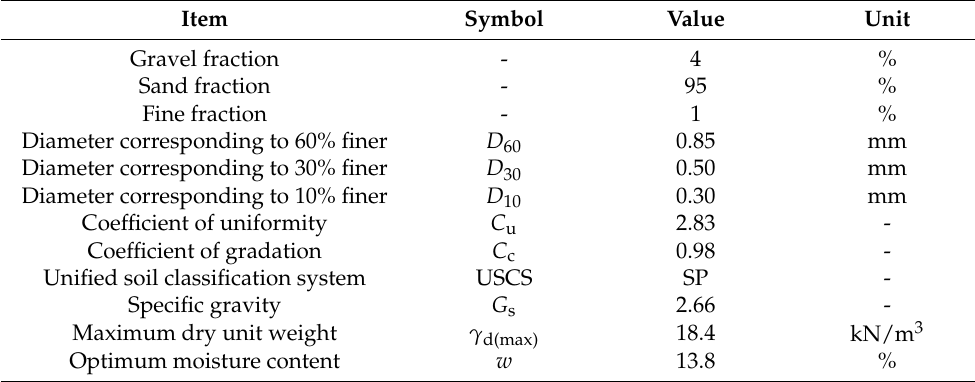
Figure 1. ( a ) cement, ( b ) sand, ( c ) SEM photo and ( d ) particle size distribution curve of sand, and ( e ) uniaxial geogrid used in this study. Table 1. Geotechnical engineering properties of sand utilized in this